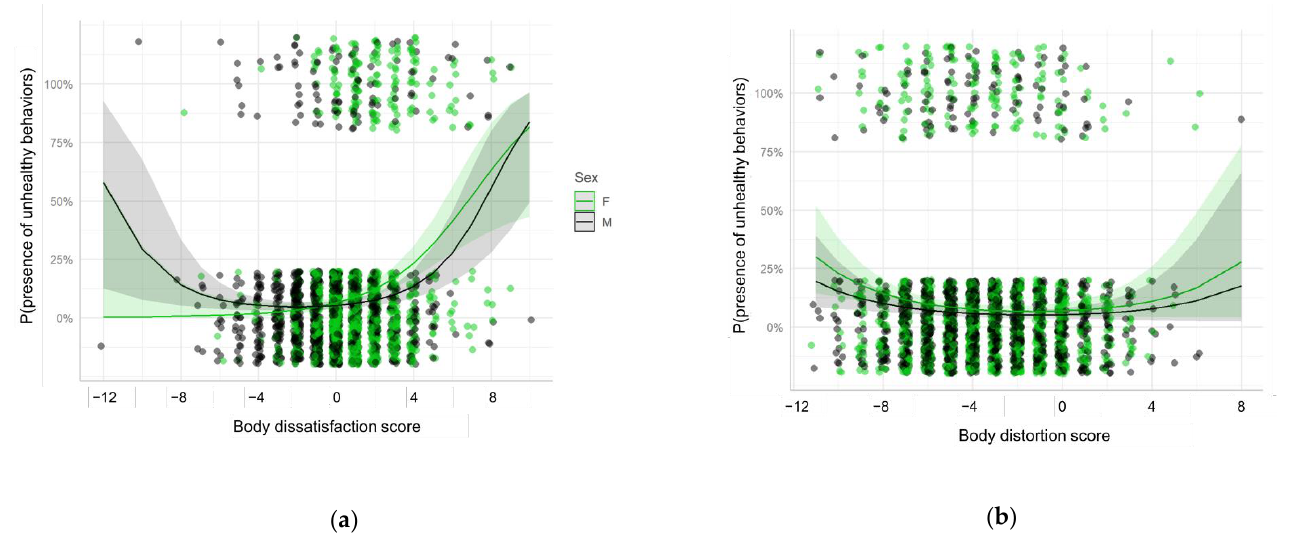
Figure 2. Random-intercept mixed effects logistic regression model for the presence of unhealthy weight control behaviors as a function of ( a ) Body dissatisfaction score; ( b ) Body distortion score; and their interaction with sex. Each point represents a participant, the lines represent the fitted model and the shades represent the 95% confidence interval. The points are slightly jittered in order to avoid overplotting. F: Female; M: Male.